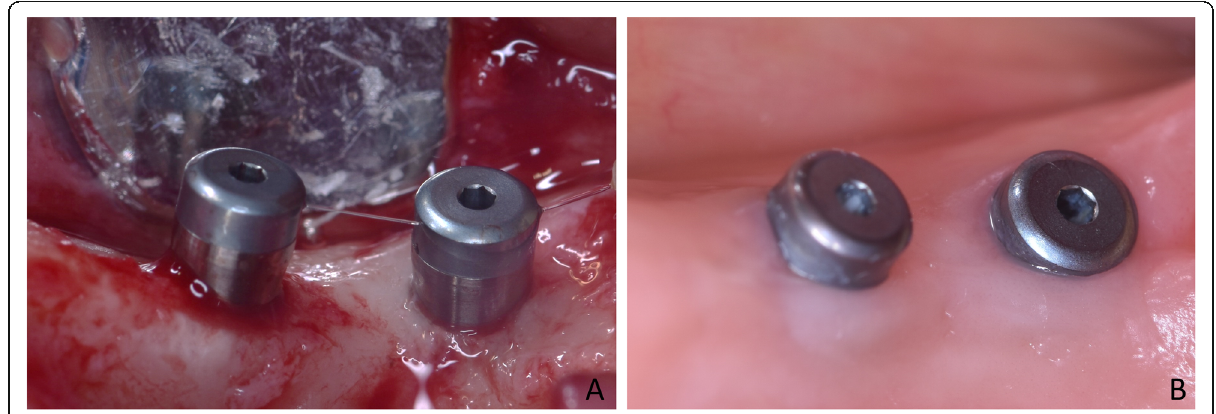
Fig. 2 Two devices installed, one using insertion torque of < 10 Ncm ( a ) and one of ~ 30 Ncm ( b